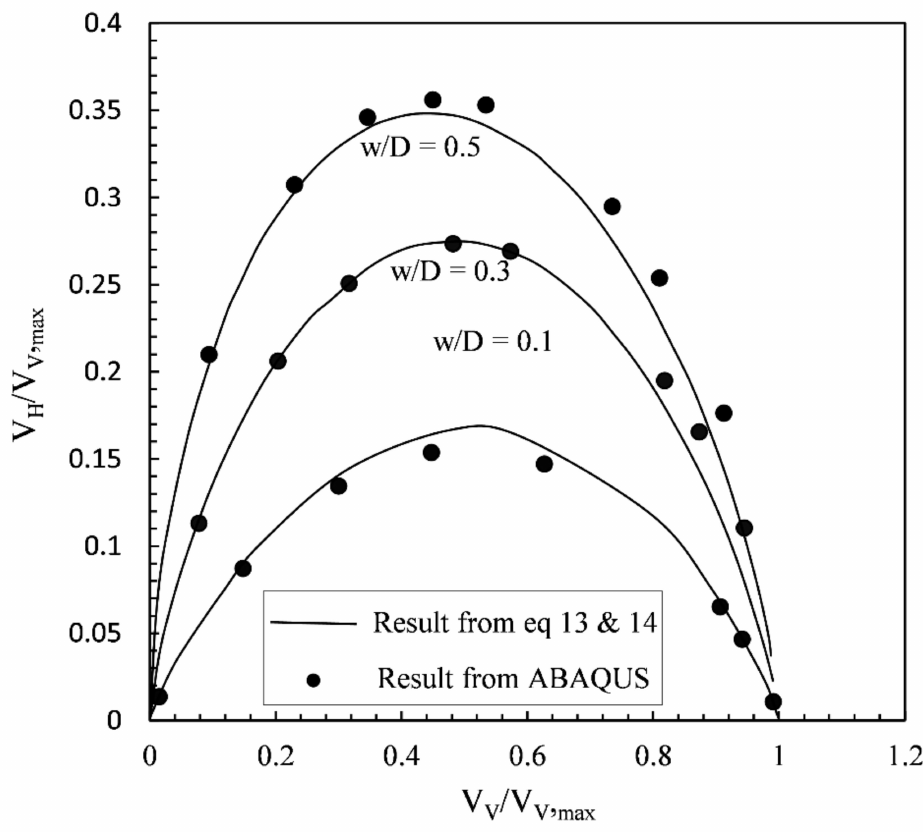
Figure 6. Comparison of predicted results from Equations (13) and (14) with results obtained from FE Analysis